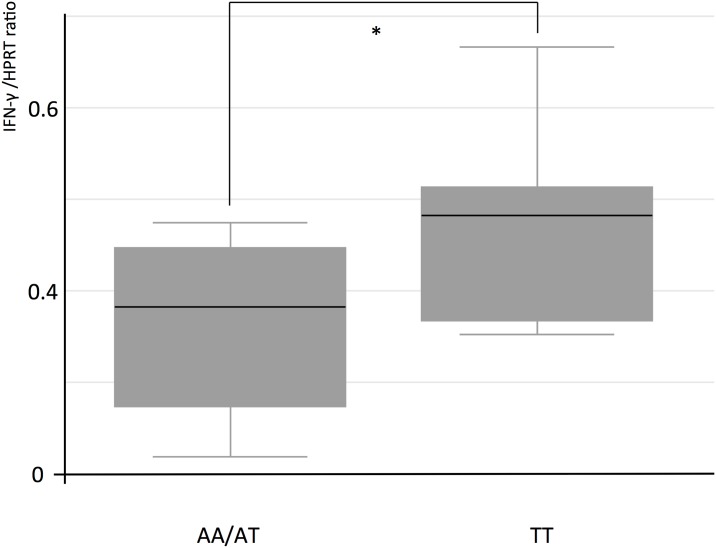
IFN-y expression in M. bovis BCG stimulated cultured PBMCs.Comparison of IFN-y mRNA expression in M. bovis BCG stimulated cultured PBMCs of Ghanaian individuals carrying either the TT genotype or the AT/AA genotype of TLR1 SNP rs3923647. Comparison of IFN-y levels yields a significant difference between TT and AT/AA carriers (* P = 0.05, T-test).